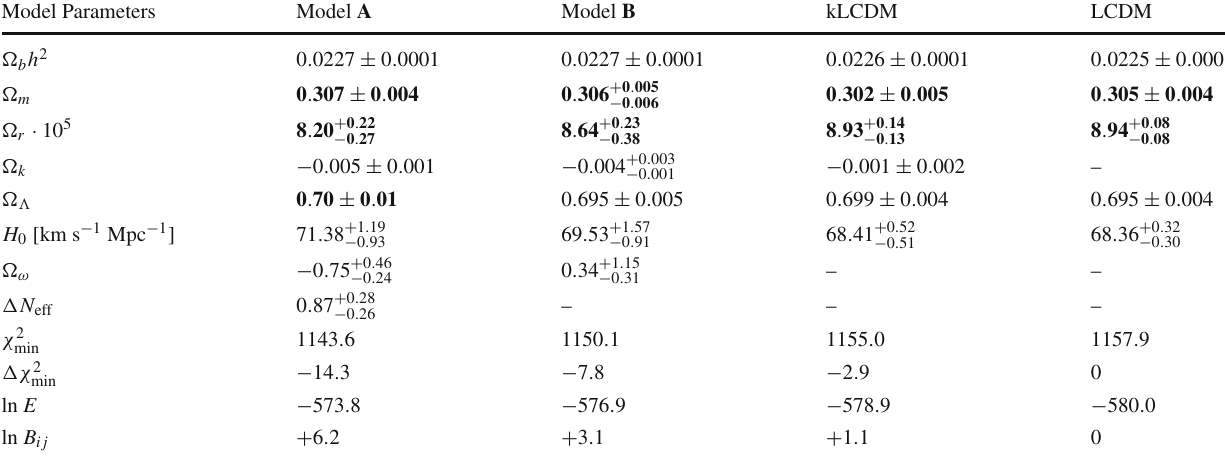
we show χ 2 for the best-fit values of parameters, the (logarithmic) min Bayesian evidence ln E , and the Bayes factor ln B ij with respects to LCDM. (cid:17)χ 2 represents the difference of χ 2 from those of LCDM. min min The bold-faced quantities represent the derived quantities